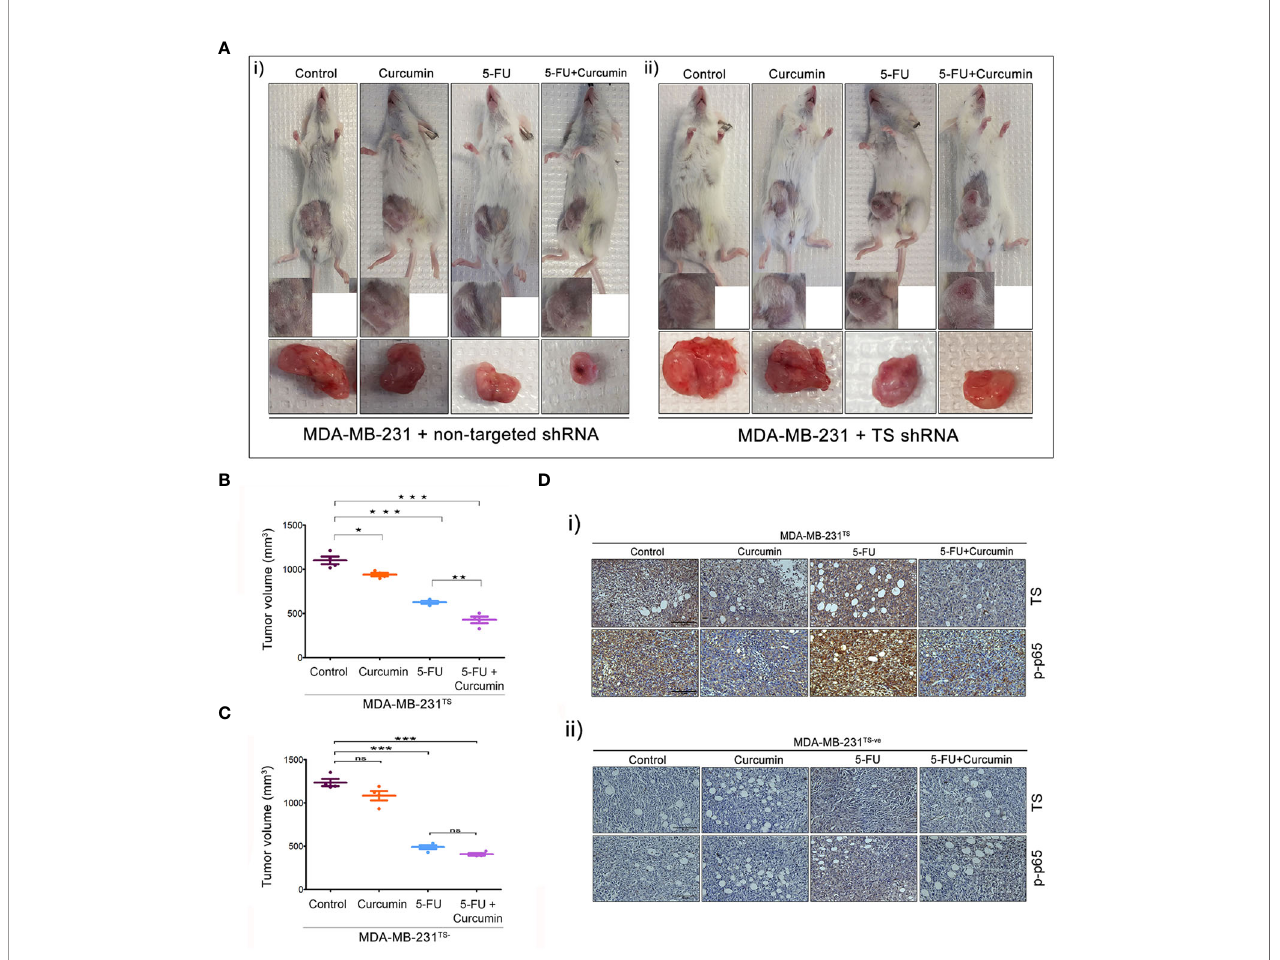
FIGURE 5 | The role of TS in regulating the synergism of 5-FU and curcumin. [ A (i, ii)] Representative images of animals from each experimental group, bearing tumor produced by orthotopic injection of both sets of transduced cells and tumors excised showed a reduction in tumor size upon completion of treatment. (B, C) Graphs showing a comparison of tumor volume of MDA-MB-231 TS and MDA-MB-231 TS- xenografts, respectively upon completion of treatment. Signi fi cant reduction in tumor volume is observed in animals bearing MDA-MB-231 TS xenografts, upon treatment with combination while no signi fi cant reduction in tumor volume is observed in animals bearing MDA-MB-231 TS- xenografts. Data represent two independent sets of experiments and results are shown as the mean ± S.D. P-values were calculated with one- way ANOVA. ***P-values ≤ 0.001, **P-values ≤ 0.01 and *P-values ≤ 0.05; ns represents non-signi fi cance. [ D (i, ii)] Immunohistochemical analysis of expression status of TS and p65 sub-unit of NF- k B in different treatment groups of MDA-MB-231 TS and MDA-MB-231 TS- xenografts,